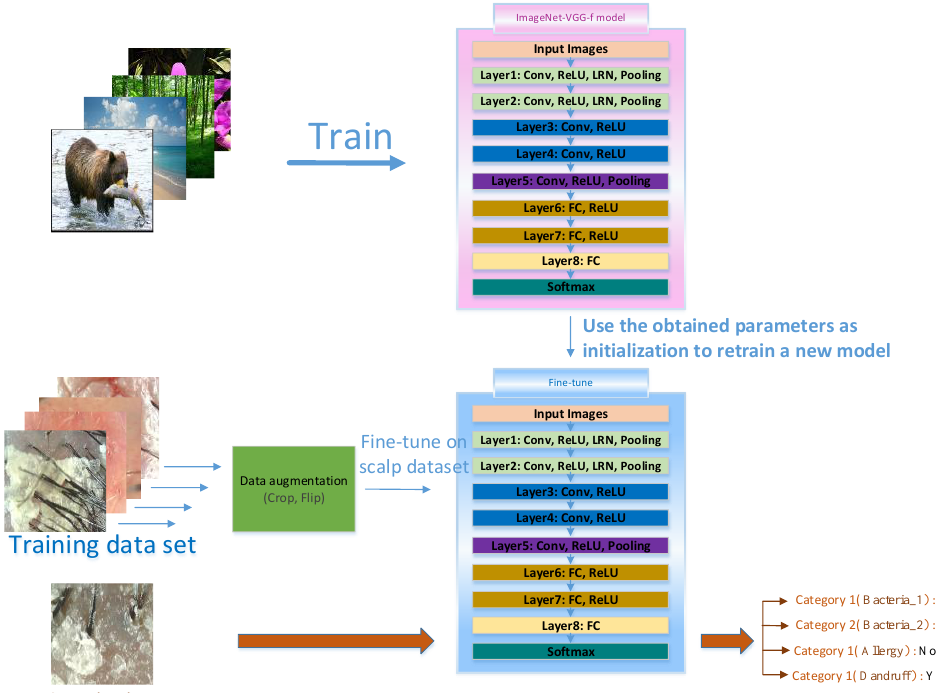
Figure 3. System architecture of the intelligent scalp detection system (ISDS).